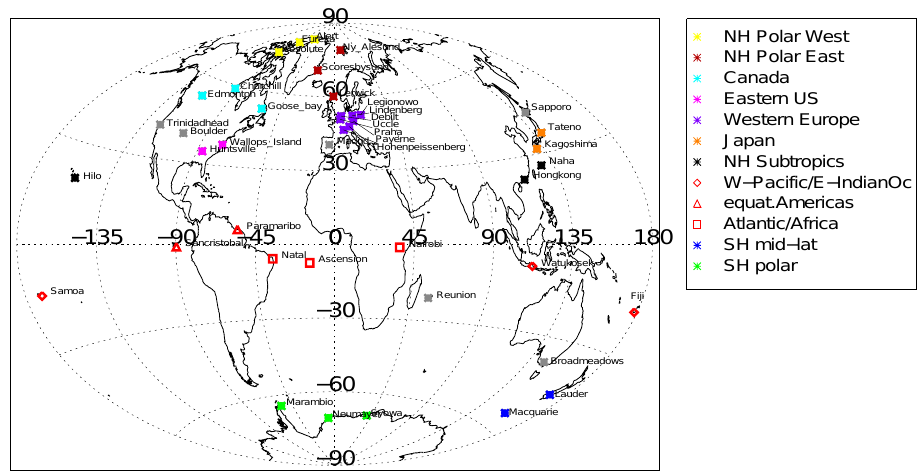
Fig. 1. Selected ozonesonde launch locations. Different colors denote different regions: NH Polar East: brown, NH Polar West: yellow, Canada: cyan, Eastern United States of America (US): pink, Western Europe: purple, Japan: orange, NH Subtropics: black, SH Mid-latitudes: blue, SH Polar: green. The Tropics, red, are further divided into: West Pacific/East Indian Ocean (diamonds), equatorial Americas (triangles), and Atlantic/Africa (squares). Those stations that are not included in selected regions are shown in